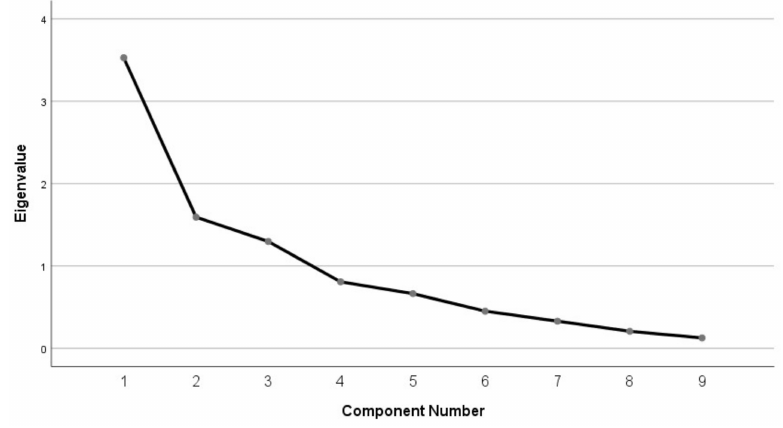
Figure A1. Scree plot of nine CANTAB components. A Varimax with Kaiser normalisation orthogonal rotation was employed. Each vari- able predominantly loaded (>0.50) onto 1 of the 4 components only. Component loadings are presented in Table A3; values greater than 0.40 are considered to have loaded onto the factor. Table A3. Four factor PCA component loadings for CANTAB